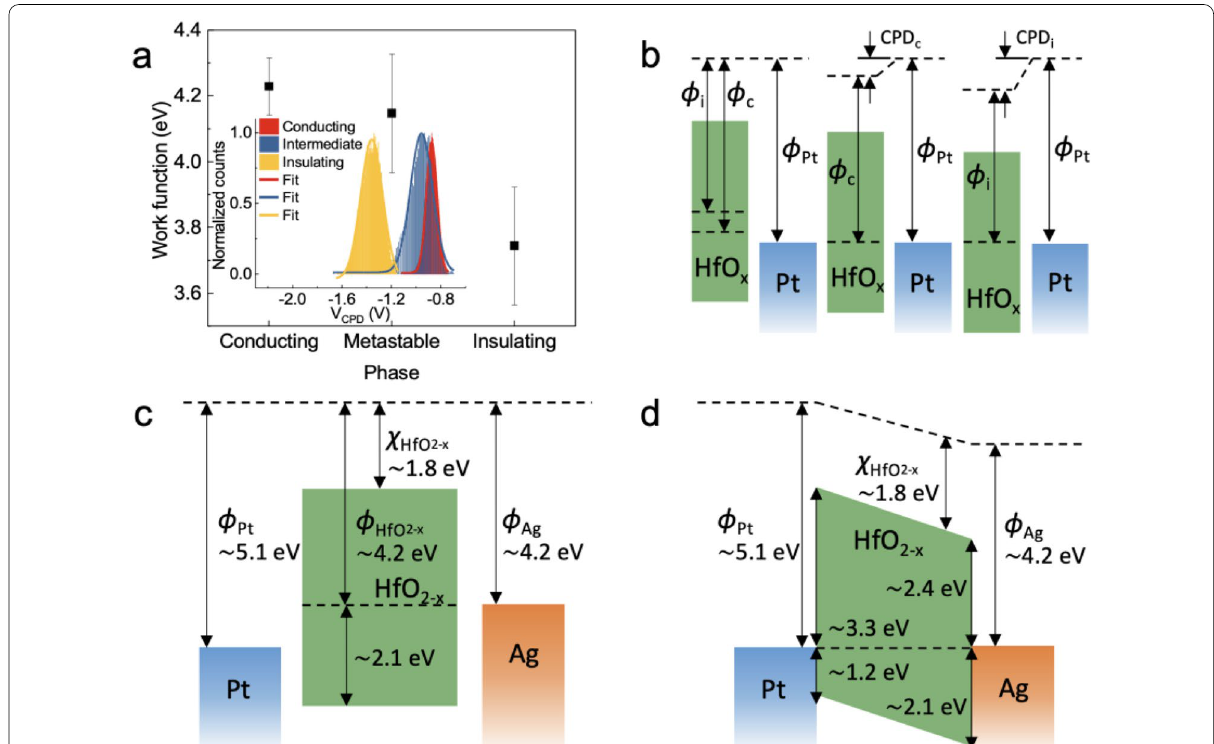
Fig. 3 a Work function modification for various electrical phases of HfO 2- x . The inset shows histograms of CPD maps. b Schematics of different work functions with different CPDs in the conducting and insulating states (denoted by c and i, respectively). Band diagrams of Pt/HfO 2-x /Ag structure of c before and d after